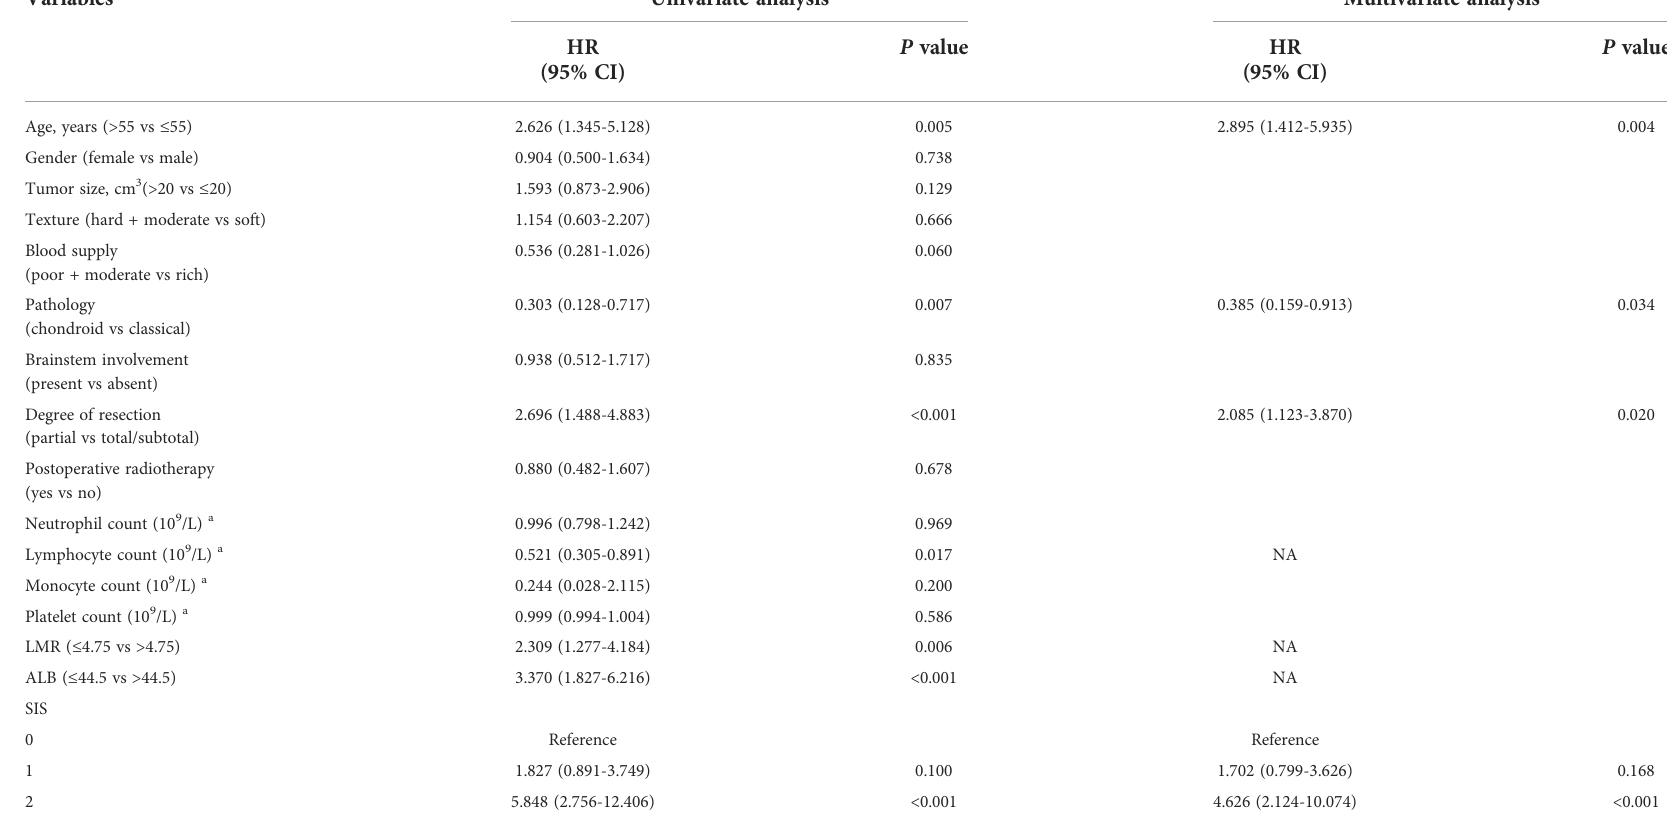
TABLE 2 Univariate and multivariate Cox proportional analysis of OS in the training